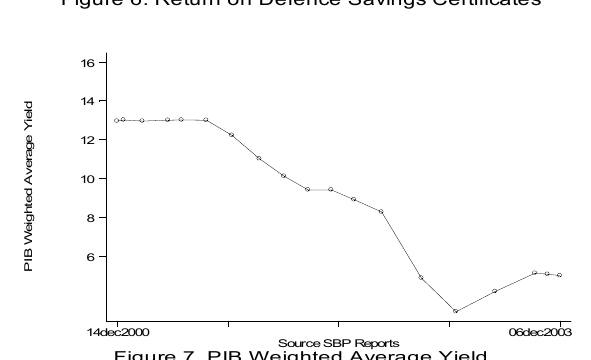
Reports1999m7 Source SBP Figure 6. Return on Defence Savings Certificates